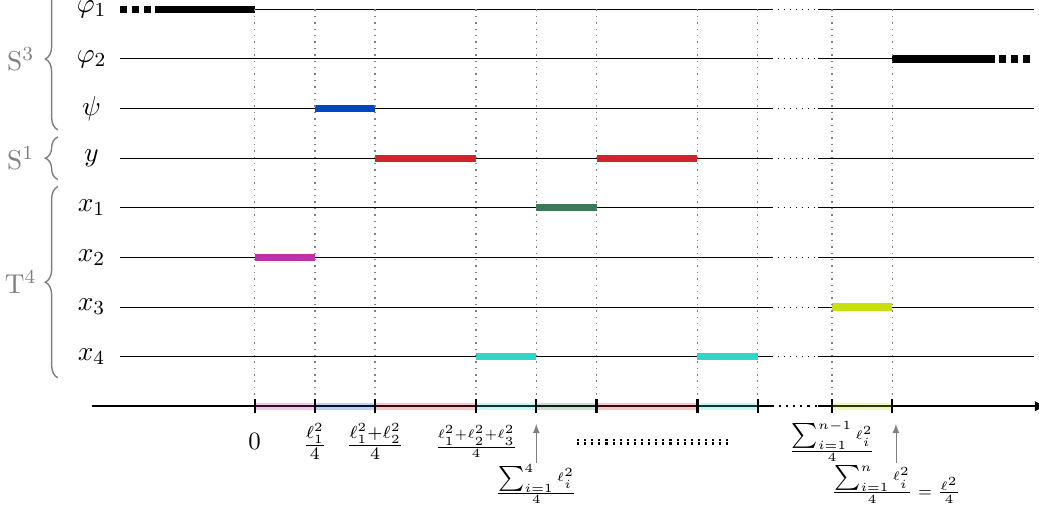
Figure 10 . Rod diagram of the shrinking directions on the z -axis after sourcing the solutions with n connected rods that induce the degeneracy of either the S 1 or a T 4 direction or the S 3 Hopf angle.